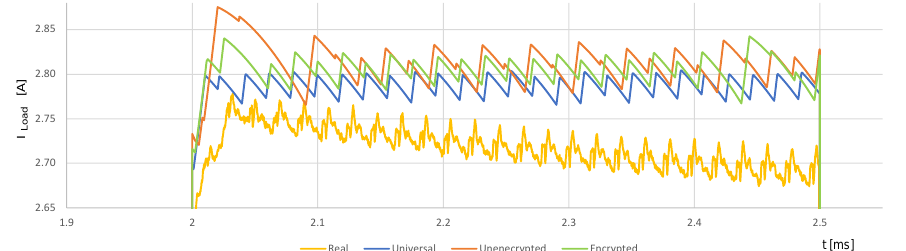
Figure 25. Detailed I Load models and real measurement time graph curves in case of dynamic load.